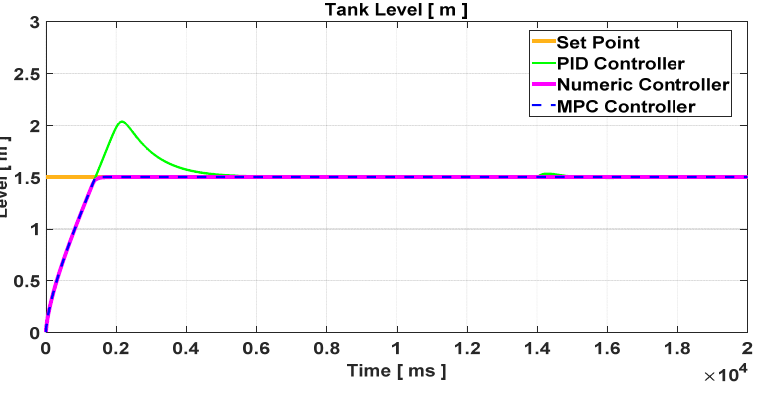
Figure 14. Performance of control algorithms in the variable level.